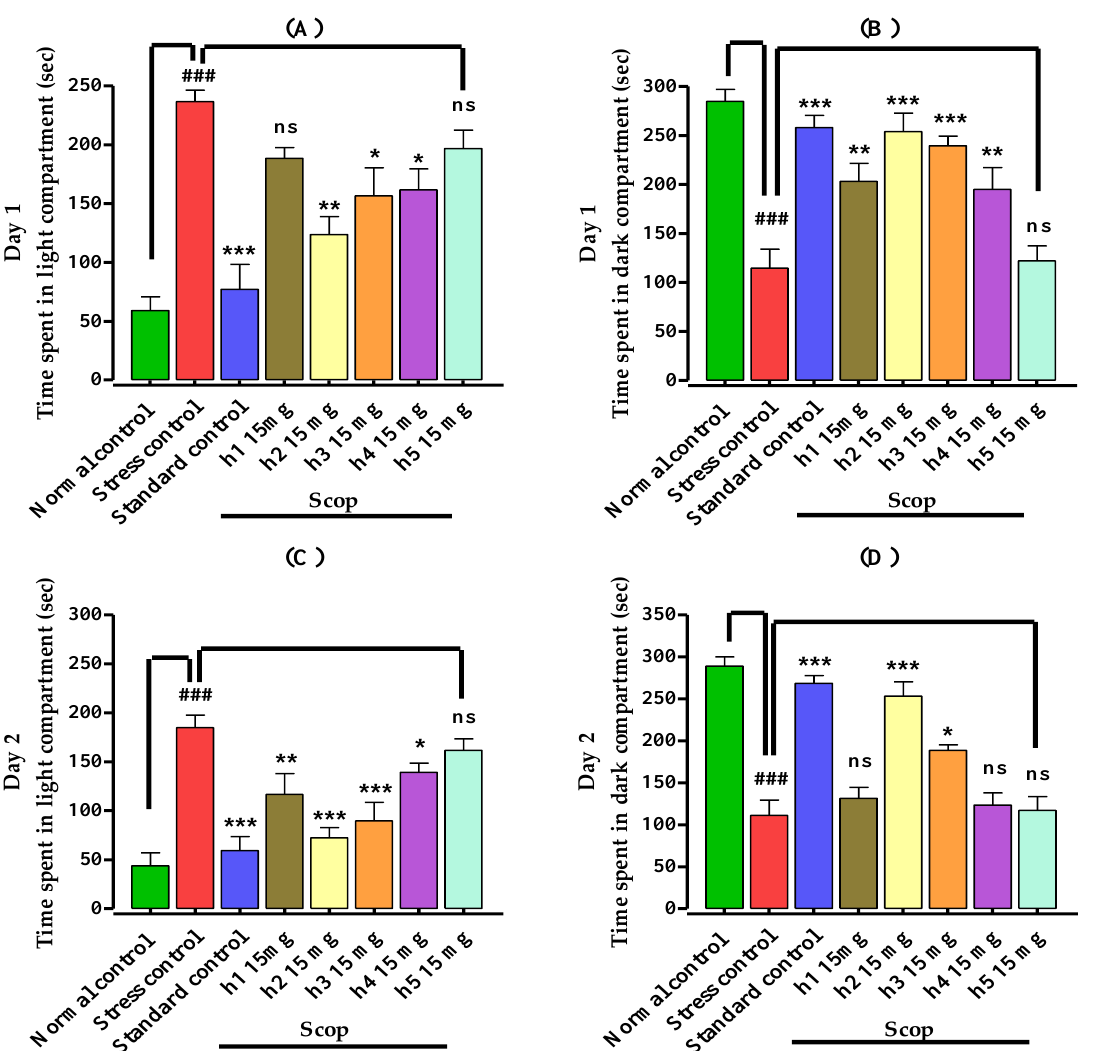
Figure 2. Effect of mono-carbonyl curcumin analogues ( h1 – h5 ) in the light–dark test on ( A ) time spent (s) on day 1 in light compartment, ( B ) time spent (s) on day 1 in dark compartment, ( C ) day 2, time spent (s) in light compartment, and ( D ) day 2, time spent (s) in dark compartment. Results are shown as mean ± SD, n = 8. Kolmogorov–Smirnov test was applied for normality distribution and each data set was found to have a normal distribution. One-way ANOVA, followed by Bonferroni’s multiple comparison tests (post hoc), was applied and expressed as ### p < 0.001 vs. normal control group, and *** p < 0.001, ** p < 0.01, * p < 0.05, “ ns ” p ˃ 0.05 vs. stress control group.